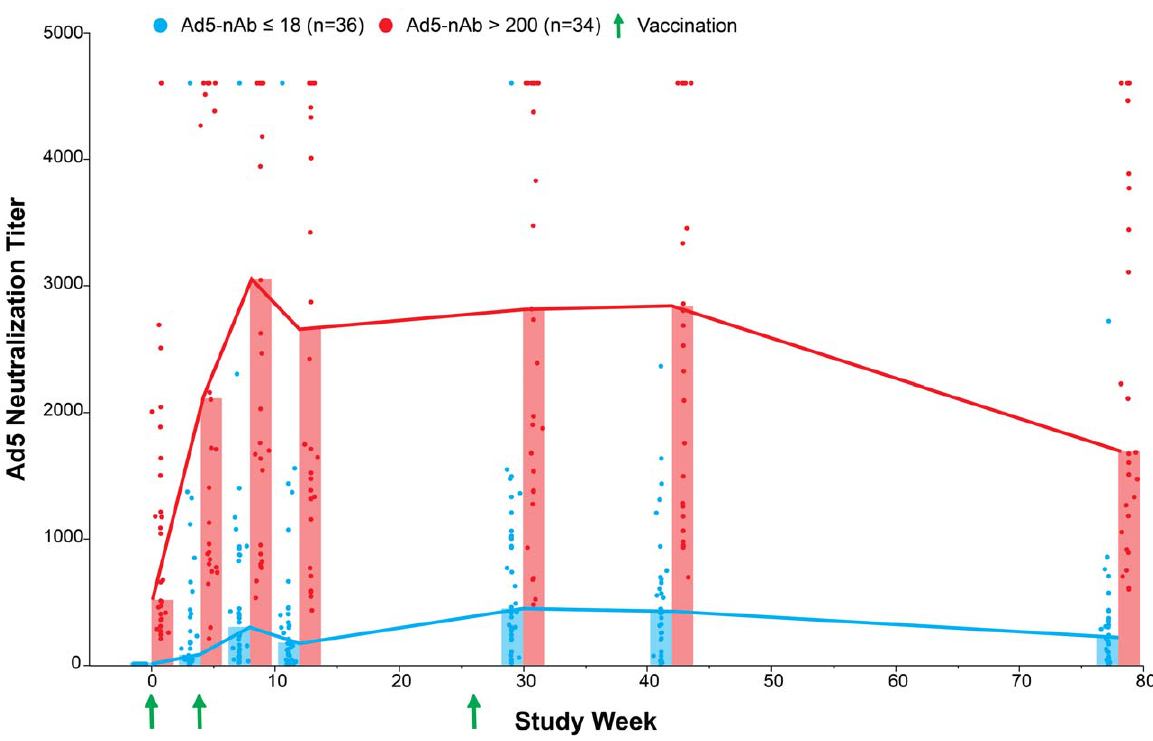
Figure 4. Ad5-specific neutralizing antibody titers before and after the MRKAd5 HIV-1 gag vaccine regimen. Serum samples collected at regular intervals during the vaccination schedule from Ad5-seronegative (n=35, blue dots) and Ad5-seropositive (n=34, red dots) vaccine recipients were assayed for Ad5 neutralizing antibody activity. Vaccination visits at 0, 4, and 26 weeks are indicated by green arrows. Bars indicate median neutralizing titers for each group at a given time